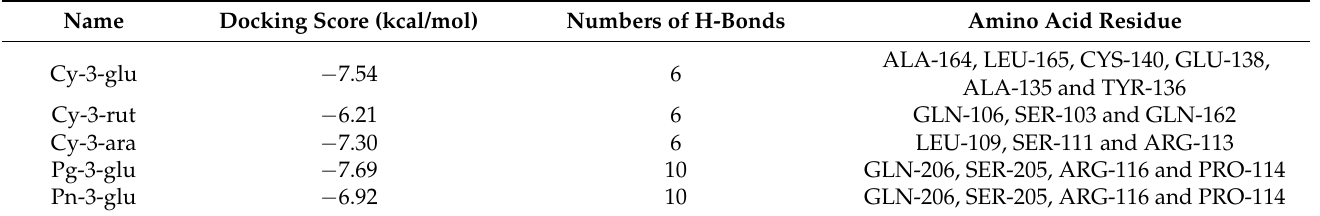
Table 2. Predicted binding affinity for anthocyanidins present in extracts docked with